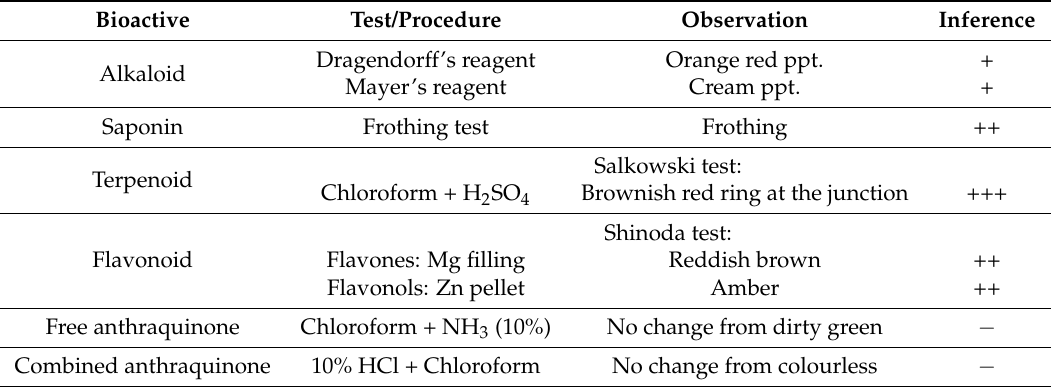
Table 1. Phytochemical screening for chemical class identification of Averrhoa bilimbi crude methanolic leaves extract. Bioactive Test/Procedure Observation Inference Dragendorff’s reagent Orange red ppt. + Alkaloid Mayer’s reagent Cream ppt. + Salkowski test: Terpenoid